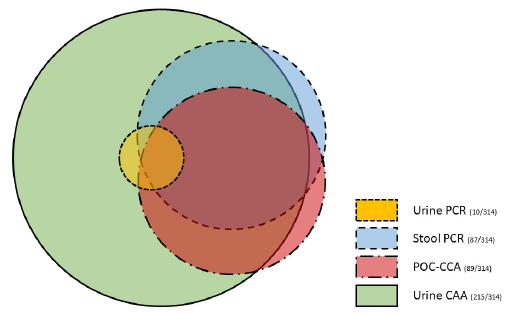
Figure 3. Proportional Venn diagram of polymerase chain reaction (PCR) in urine and stool compared to the point-of-care circulating cathodic antigen (POC-CCA) and the up-converting particle lateral flow circulating anodic antigen (UCP-LF CAA) urine test in 314 individuals. Table 2. The level of agreement between polymerase chain reaction (PCR) in urine and stool, point- of-care circulating cathodic antigen (POC-CCA), and the up-converting particle, lateral flow circu-